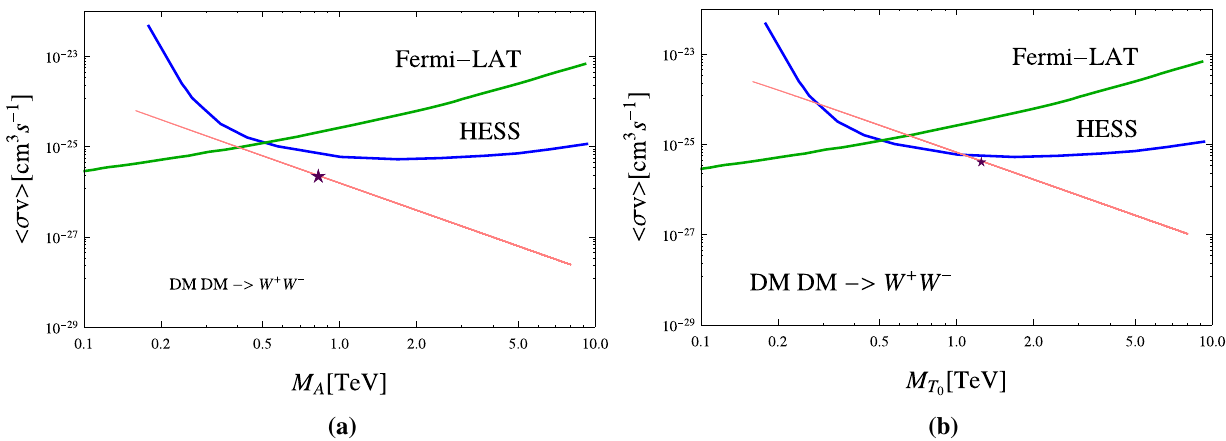
Fig. 14 (cid:4) σv (cid:5) in W ± W ∓ mode verses the DM mass as shown by pink lines in a for IDM and in b for ITM respectively. The Blue line cor- responds to the H.E.S.S bounds [76] and the green line corresponds to